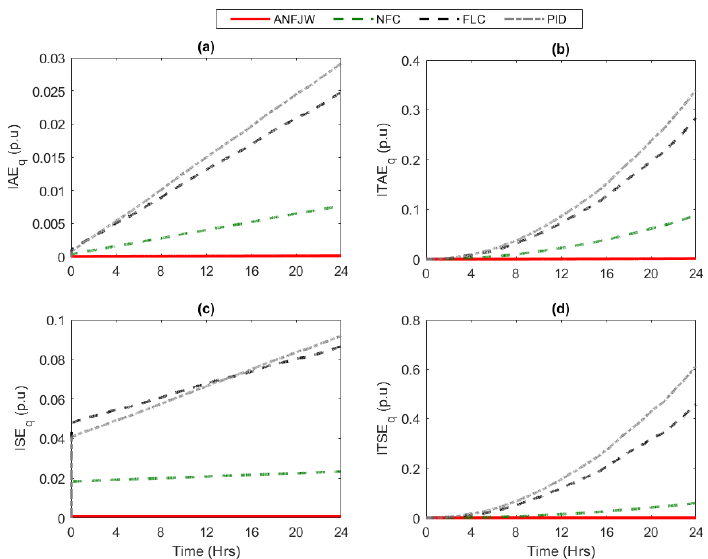
Figure 18. Dynamic performance comparison using active power: ( a ) integral absolute error (IAE), ( b ) integral time absolute error (ITAE), ( c ) integral square error (ISE), and ( d ) integral time square error (ITSE).